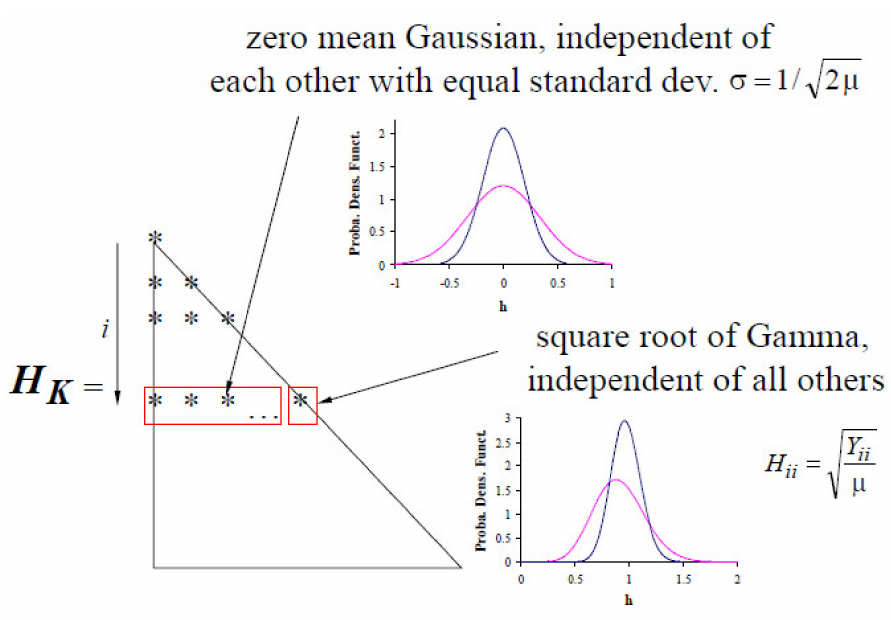
Figure 10. Structure of the random H K matrices with n = 8, i = 2, and µ = 4.5 and